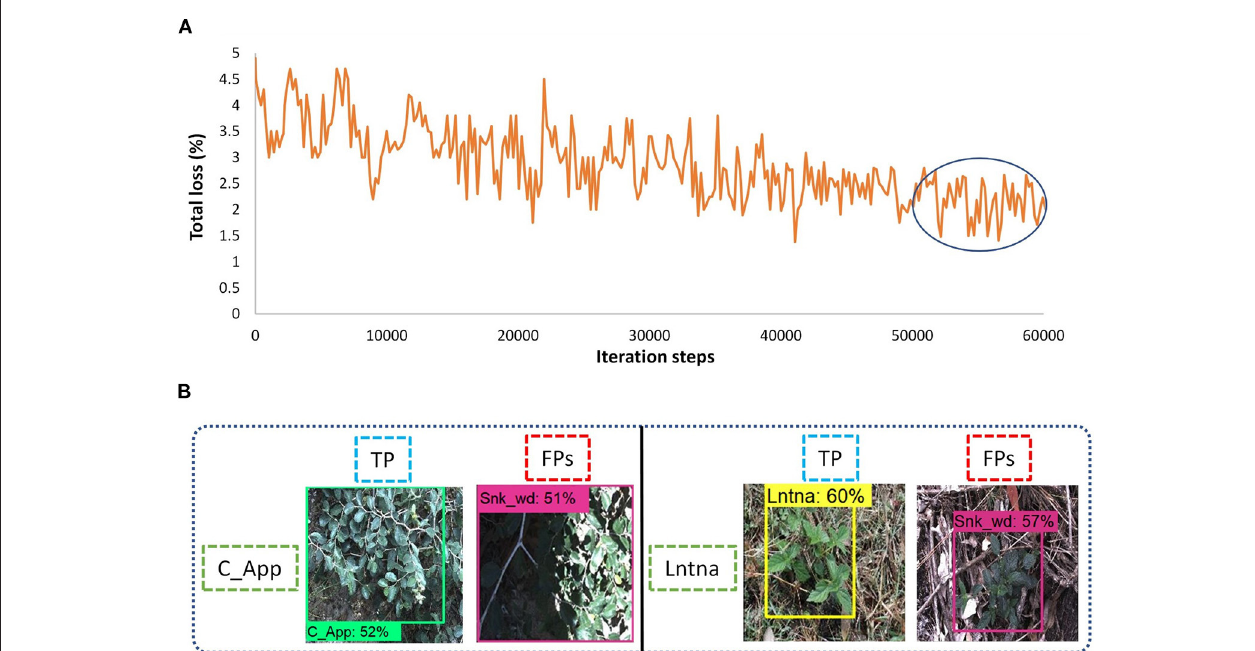
FIGURE 7 | Performance of the CenterNet model: (A) total loss; (B) false-positive results for the chinee apple, and lantana classes.